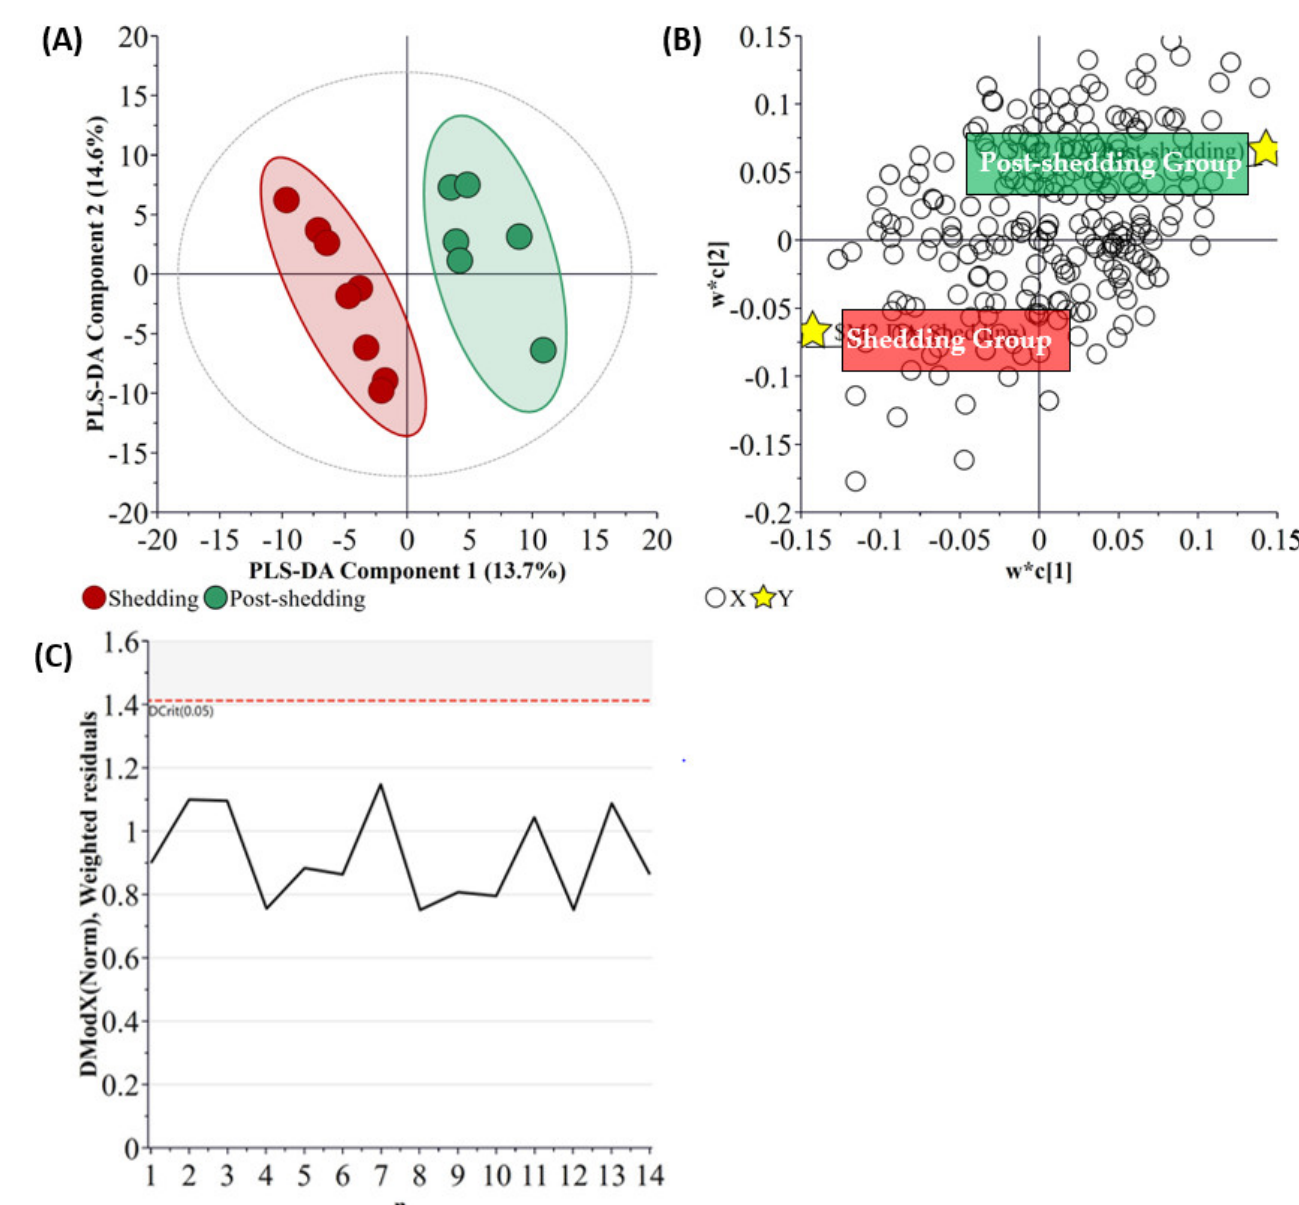
Figure 5. Partial least square-discriminant analysis ( A ) scatter plot, ( B ) loading plot, and ( C ) distance of observation plot of nasal wash samples collected from Ferrets. R 2 X (cum) = 0.535, R 2 Y (cum) = 0.999, Q 2 = 0.650. The ellipse presented in Figure 5A represents Hotelling’s T2 confidence limit (95%). The colored circles in panel ( A ) represent each analyzed sample, while the yellow-colored stars in panel ( B ) indicate the average group position for each sample cluster, with the white circles representing the distribution of metabolite features between these groups.